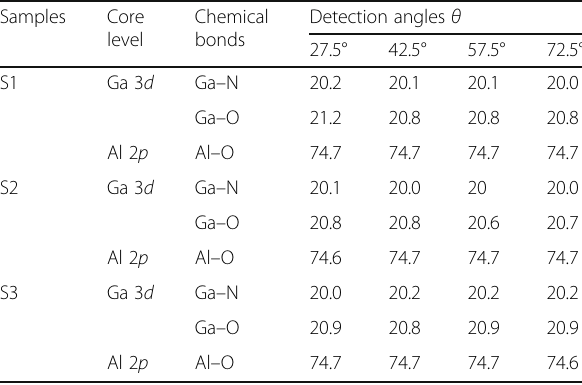
Table 1 Summary of the BEs (eV) of Ga 3 d and Al 2 p at different detection angles for all the samples, with the error of ± 0.1